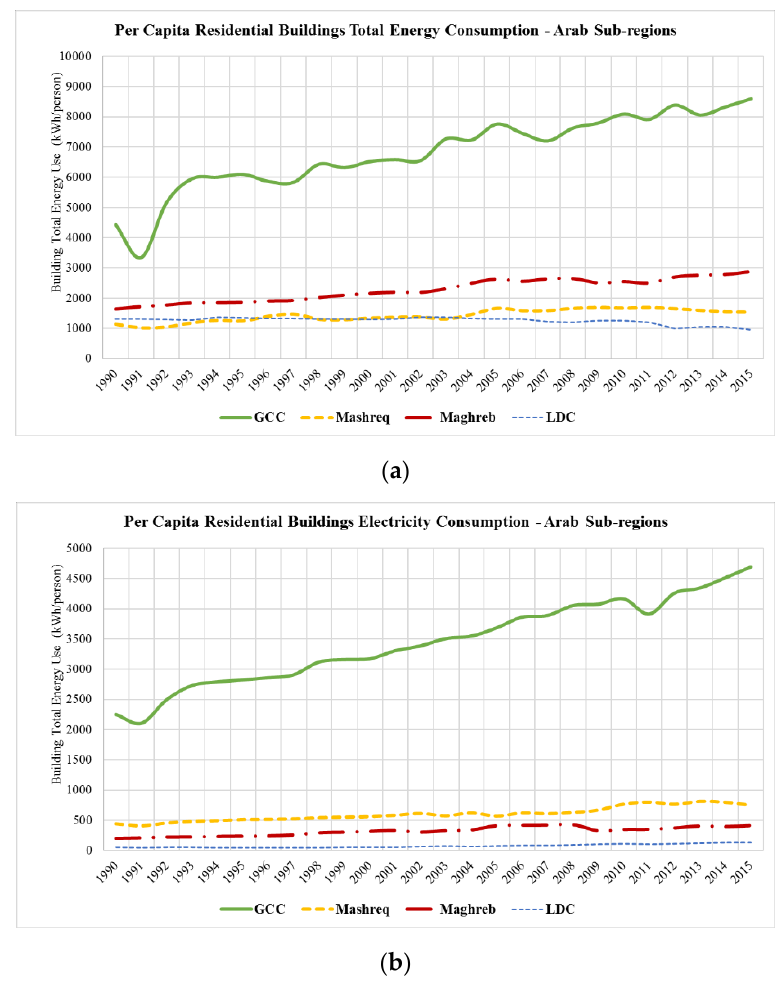
Figure 15. Annual per capita residential building ( a ) total energy consumption and ( b ) electricity consumption per capita of the Arab sub-regions during the 1990–2015 period.